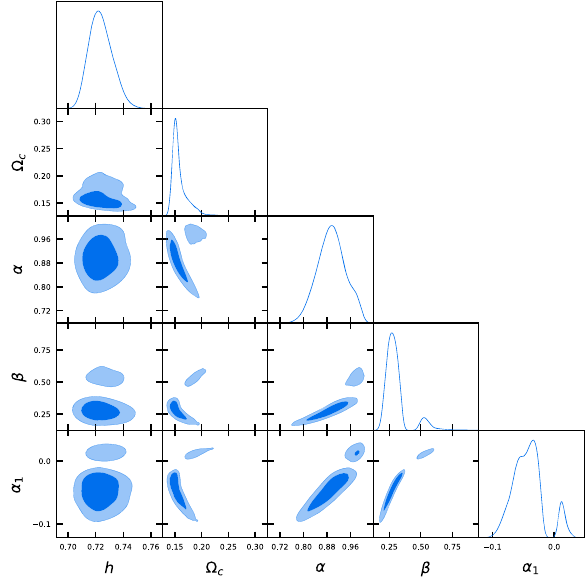
Fig. 2 ContourplotsformodelIMHRDE2withthe1 σ and2 σ regions. We considered the full joint analysis with Pantheon + CC + R19 + BAO +